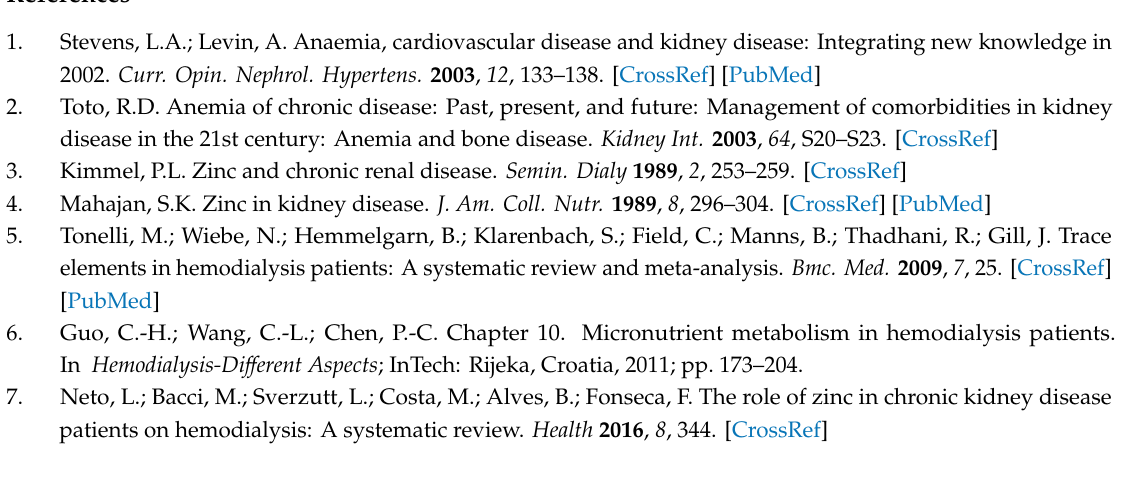
s1. Supplemental Table S1. Hematology of the 5 / 6-nephrectomized rats injected with saline, ZnSO 4 , or rHuEPO; Supplemental Table S2. Hematology of normal rats injected with saline, ZnSO 4 , or